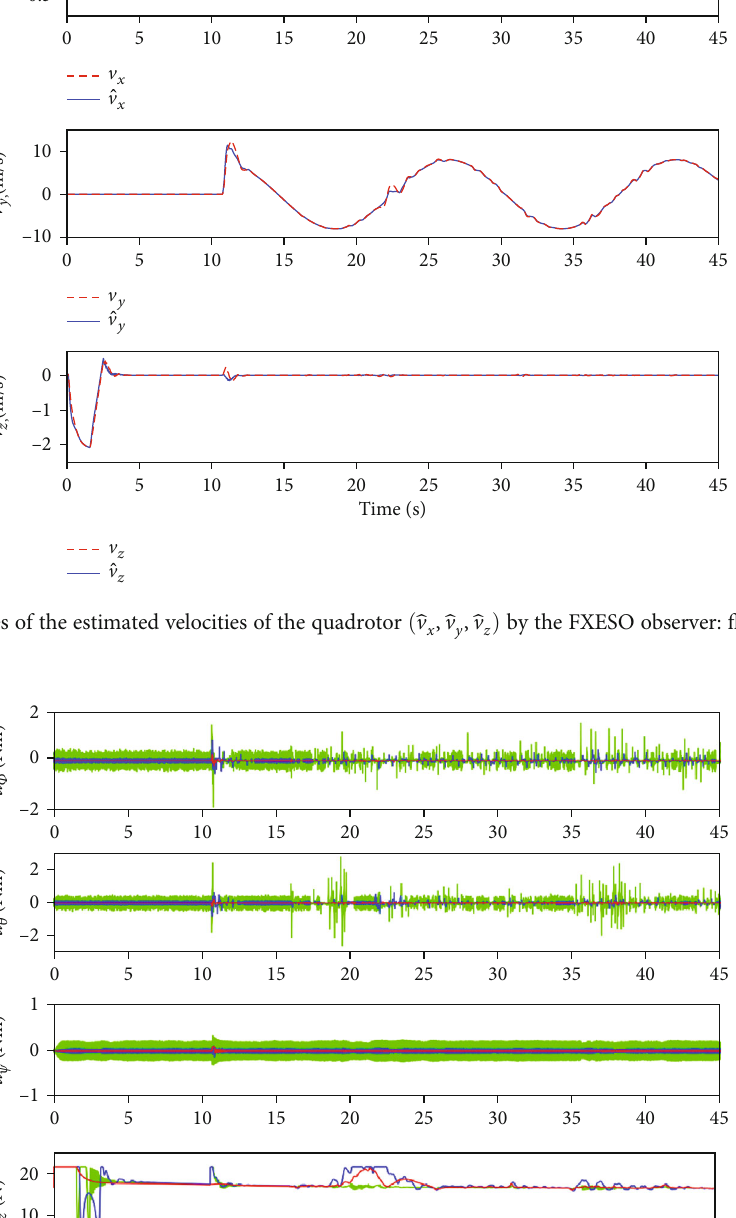
Figure 23: Control signals, i.e., ð u , u Φ , u θ , u ψ Þ , of the proposed FCS 4, FCS 2, and FCS3. The control signals of the proposed FCS 4 are z chattering-free: fl ight scenario 2.